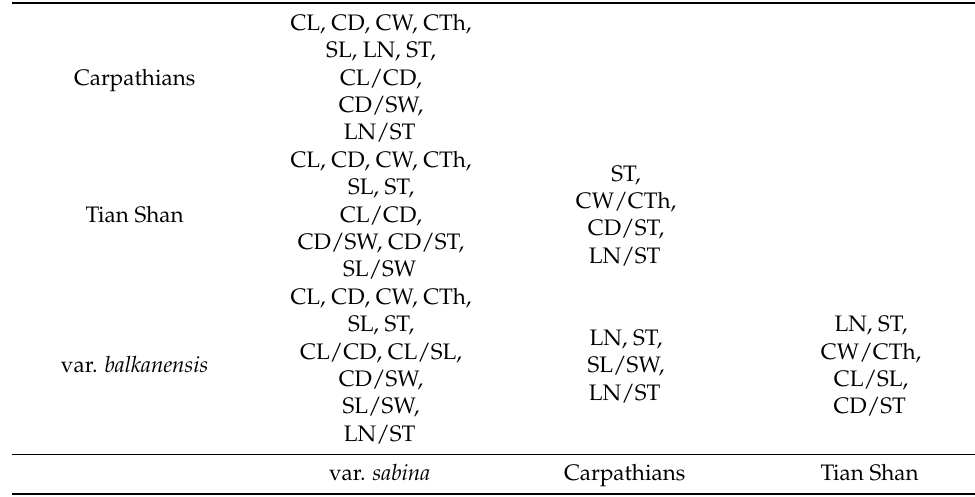
Table 3. Characteristics differing significantly two varieties of J. sabina : sabina and balkanensis and two indefinite groups of populations: Carpathians and Tian Shan, according to results of Kruskal-Wallis’ test; character codes as in Table 2.